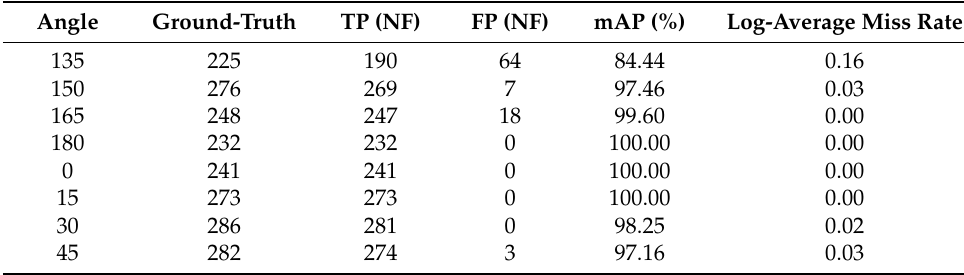
Table 14. The experimental results of different angle